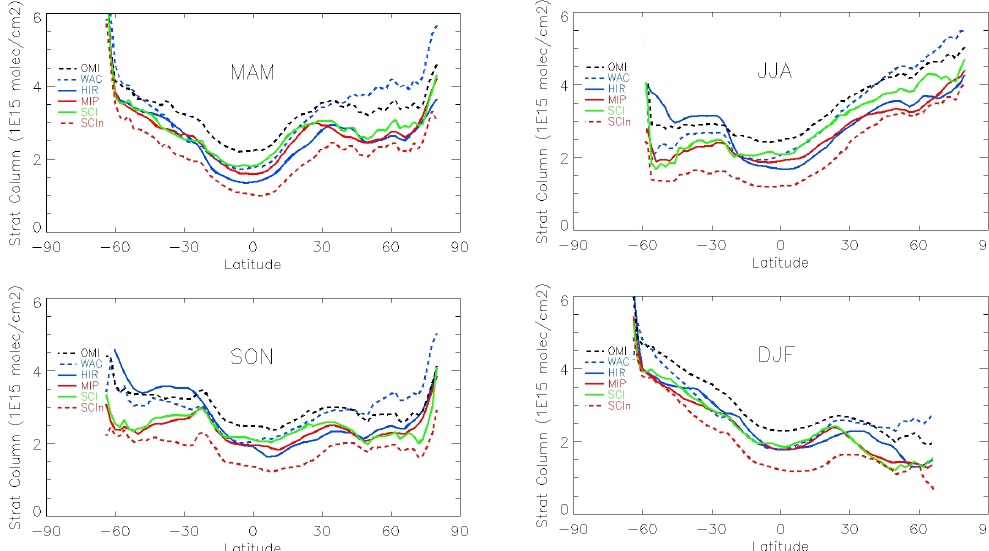
Figure 8. Seasonally averaged (MAM, JJA, SON and DJF) stratospheric NO 2 columns from SCIAMACHY limb (green), MIPAS (red), HIRDLS (blue), WACCM (dashed blue), SCIAMACHY nadir (SCIn, dashed red) and OMI (dashed black) integrated down to